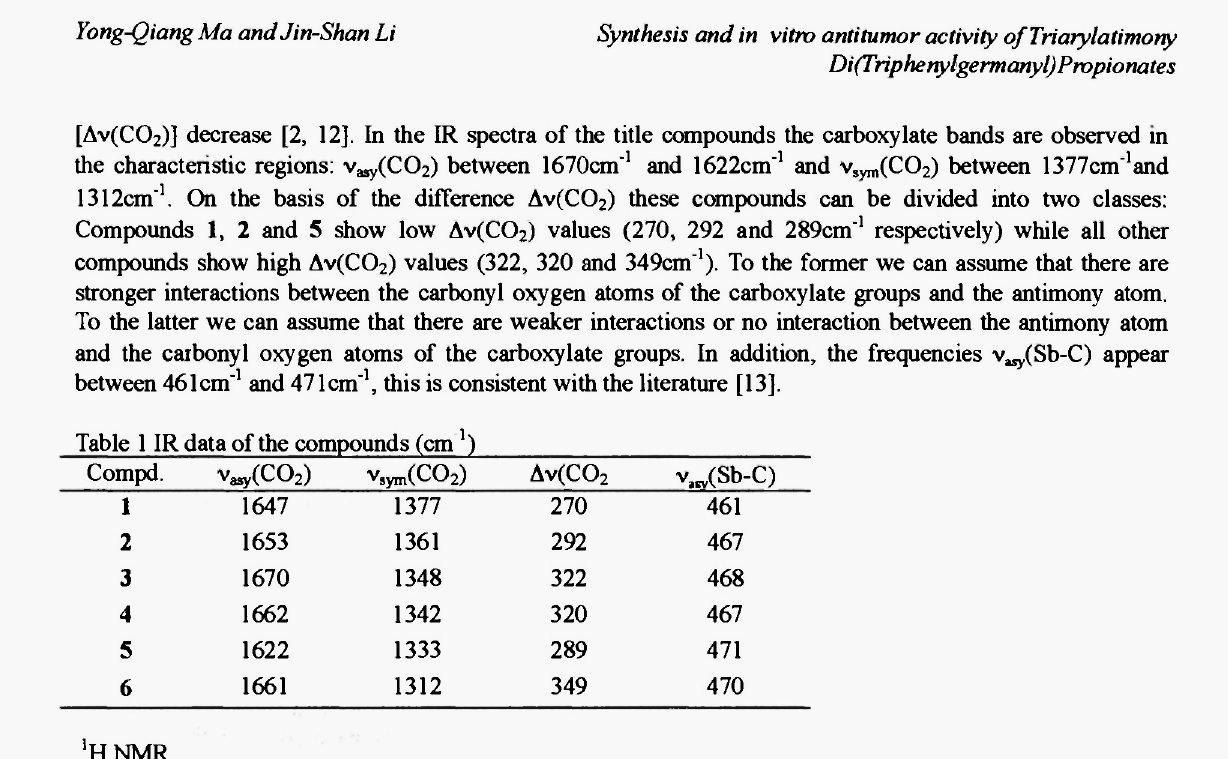
Table 1 IR data of the compounds (cm 1 ) Compd.